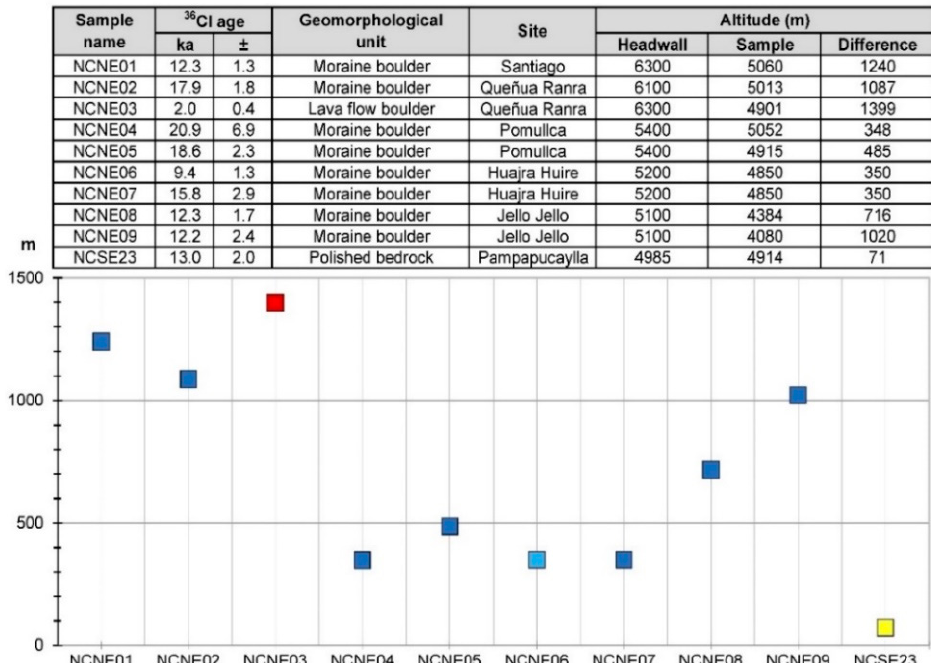
Figure 9. ( Top ): exposure ages calculated in this work: moraine boulders, polished bedrock, and lava boulder. The gray bands show the chronology of the paleolake transgressions on the Bolivian Altiplano. ( Bottom ): source area altitude of the flows (glaciers or lava) related to the sampled surfaces. The gray band shows the paleoELAs reconstructed in this work.